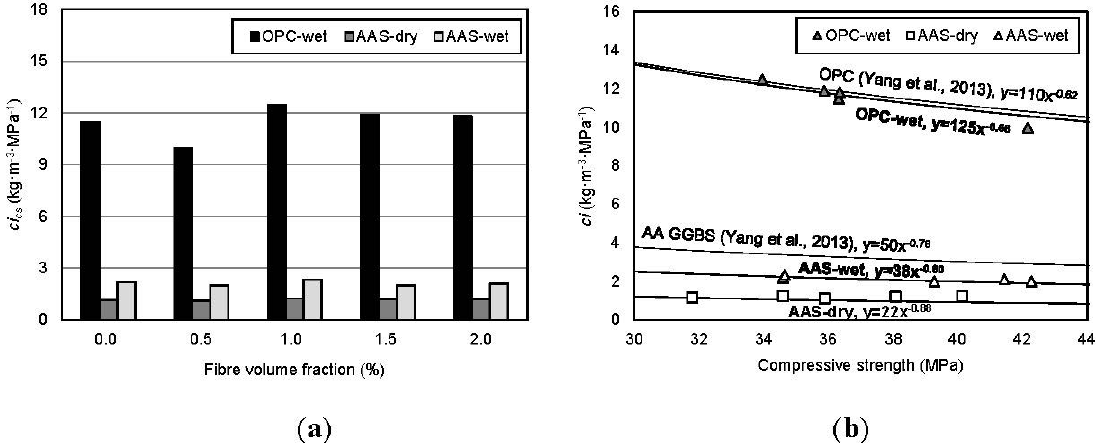
Figure 10. Comparison of CO 2 intensity ( ci ). ( a ) Fiber volume fraction; ( b ) compressive